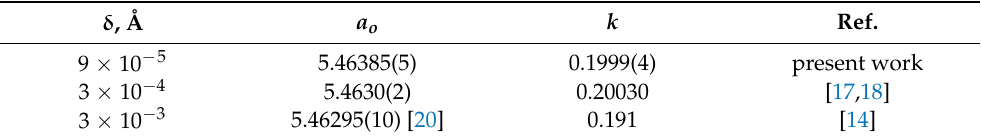
Table 2. Precision ( ± δ ) of the lattice parameter measurement and the coefficients of the